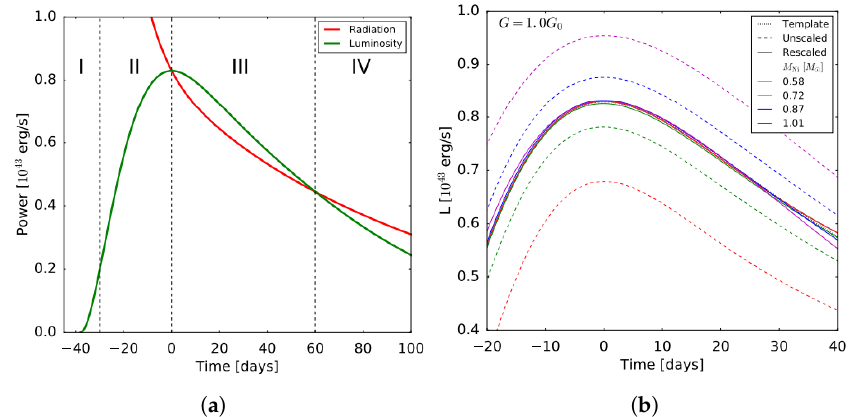
Figure 3. ( a ) Typical light curve of Type Ia supernovae along with the instantaneous power produced by the radioactive decay chain of 56 Ni divided into four phases. Adapted from: [15] ( b ) Typical Type Ia supernova light curves for different amounts of nickel-56 mass produced. Adapted from: